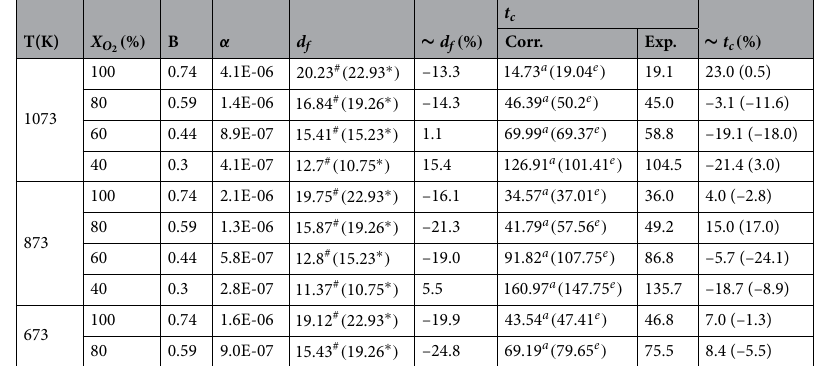
Table 5. Comparison of the film diameter and the total burn time estimated by the analytical correlations and a experiments. # Experimental data; ∗ Analytical estimate; Burn time estimated using analytically computed e film diameter; Burn time estimated using experimentally estimated film diameter; ∼ d f deviation in experimental and analytical film diameter; ∼ t c deviation in experimental and theoretical burn times.